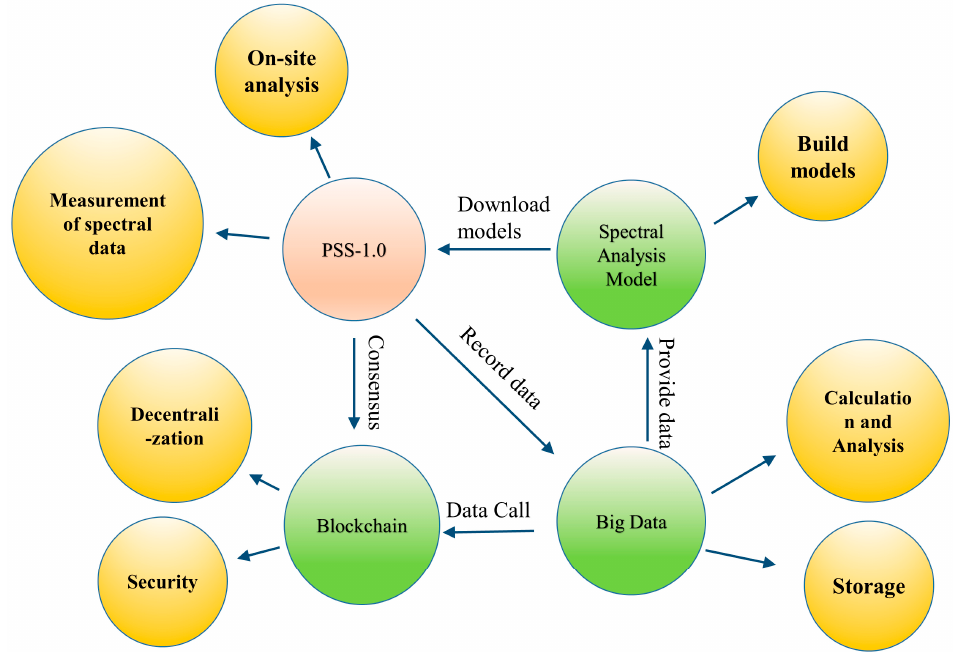
Figure 1. Portable smart spectrometer PSS-1.0 and related systems.